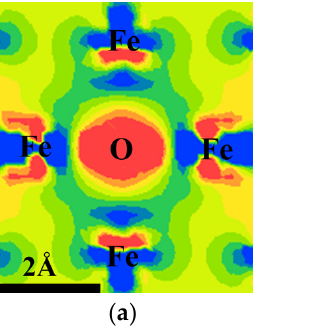
Figure 2. (1 1(cid:3364) 0) slice of charge density difference plots in the units of electron/Bohr 3 for O atom in bcc Fe matrix: ( a ) O (octahedral) in free-defect bcc Fe supercell and ( b ) O (octahedral) with 1NN v .